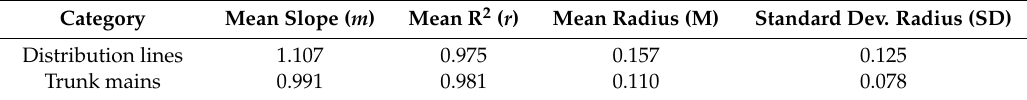
Table 3. Performance metrics for zero order models.